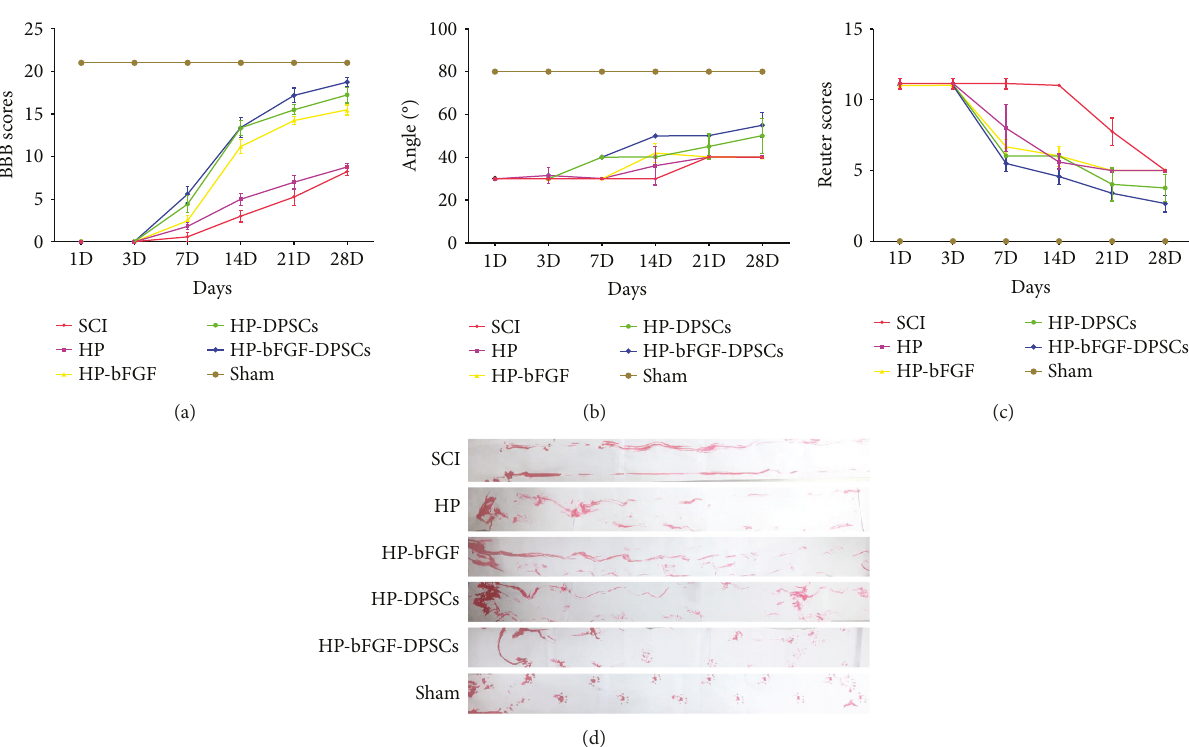
Figure 5: Motor and sensory functional recovery after SCI. (a) The BBB locomotion scores of di ff erent groups. (b) The inclined plane test scores of di ff erent groups. (c) The Reuter scores of di ff erent groups. (d) Footprint analysis of di ff erent